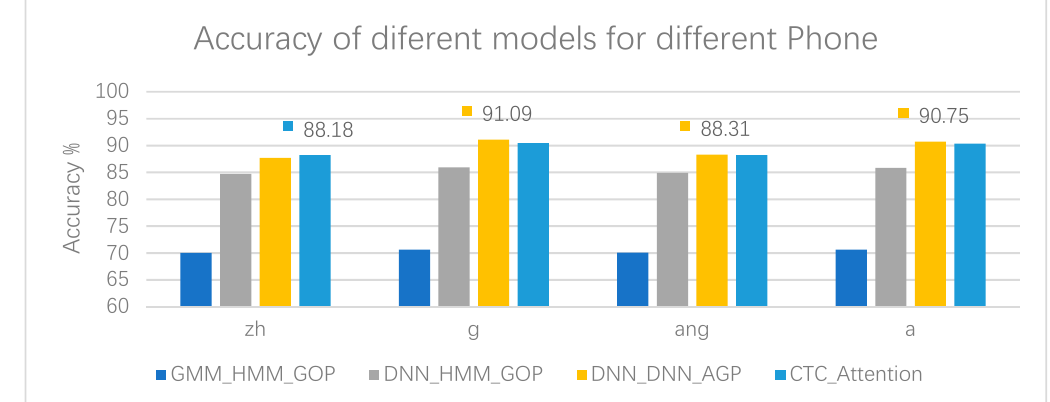
Figure 6. Accuracy of different models for four phones, zh, g, ang, and a.